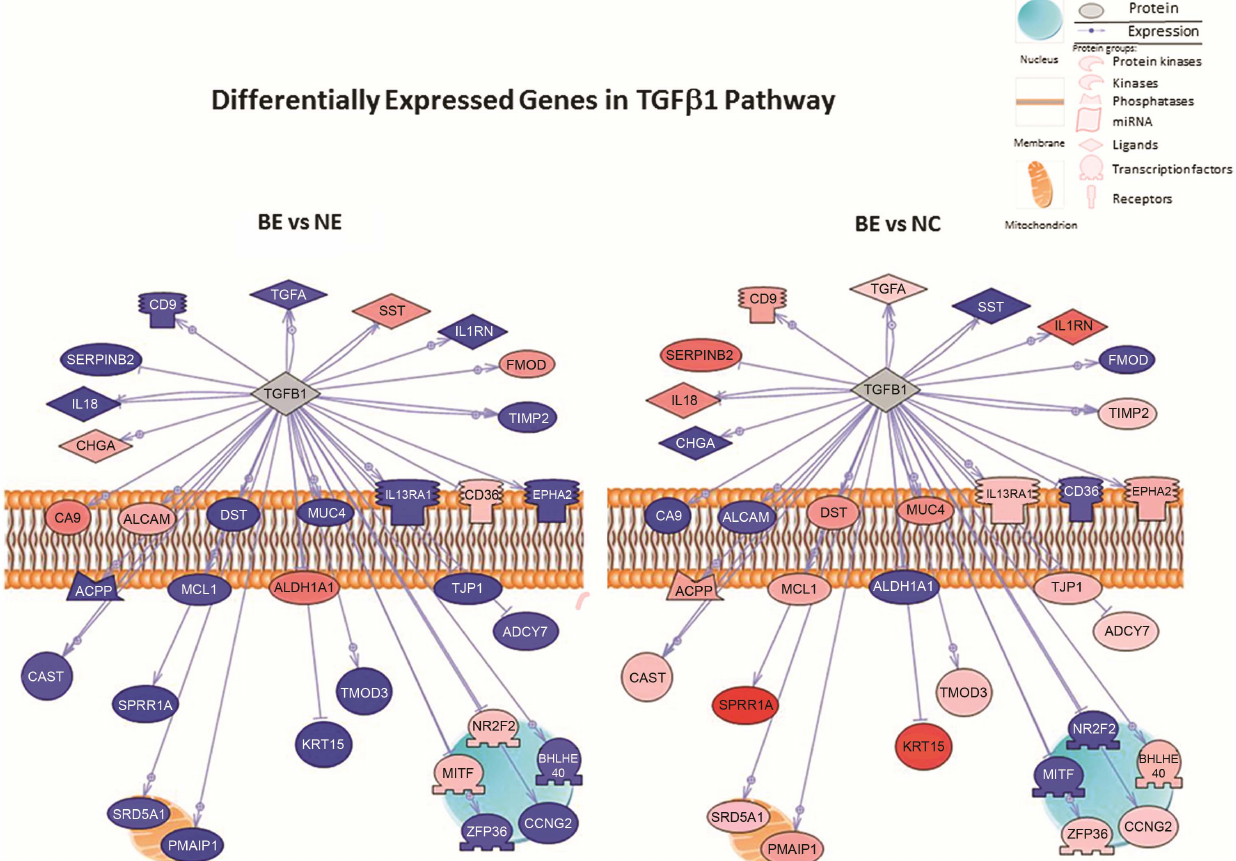
Figure 3. Pathway-based analyses of common differentially expressed genes in BE vs NE and BE vs NC comparisons. Two hundred and five overlapping genes were identified between BE vs. NE and BE vs. NC tissues after Bonferroni correction ( P , 1.12-E06) and with a 2-fold or greater differential expression. Diagram illustrates the TGF- b 1 signaling pathway in BE vs NE and BE vs NC comparative groups. The direction and/or magnitude of expression is inverse for thirty two genes in the TGF- b 1 network between the comparative groups. Genes include: SERPINB2, TMOD3, EPHA2, KRT15, ADCY7, SST, FMOD, CD36, CA9, ALCAM, IL1RN, TIMP2, CAST, MITF, SPRR1A, BHLHE40, MCL1, IL13RA1, ACPP, SRD5A1, NR2F2, ALDH1A1, DST, TJP1, CD9, TGFA, MUC4, PMAIP1, ZFP36, CCNG2, IL18 and CHGA . Data source: Signaling Pathways, Ariadne Pathways. Primary red and blue colors and shading indicate the direction and degree of differential expression with pink to red indicating degrees of increasing upregulation and light blue to darker blue indicating increasing downregulation. Grey indicates a gene product that is part of the pathway, but is absent in the experimental list tested. Abbreviations: BE, Barrett’s; NE, normal squamous epithelium; NC, normal gastric cardia epithelium.